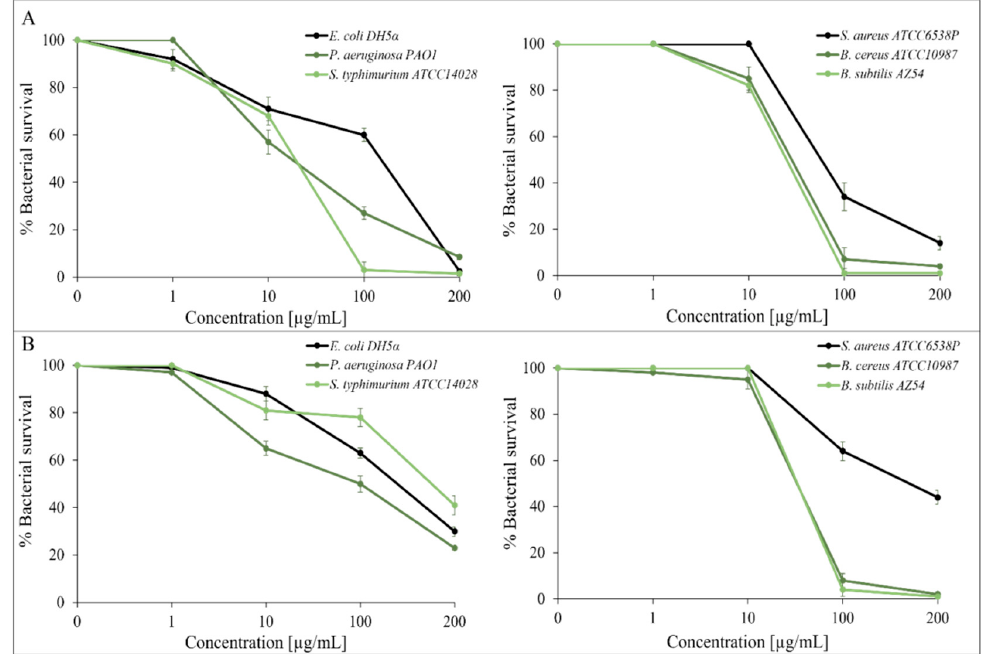
Figure 1. Antimicrobial activity of P. ferulacea flowers oil ( A ) and leaves oil ( B ) at different concentrations (0; 1; 10; 100 and 200 µg/mL) valuated by colony count assay, after 4 h of incubation, against Gram-negative E. coli DH5 α , P. aeruginosa PAO1, S. typhimurium ATCC14028 and Gram-positive S. aureus ATCC6538P, B. cereus ATCC10987 and B. subtilis AZ54. The % of bacterial survival is represented by the y axis. The assays were performed in three independent experiments.